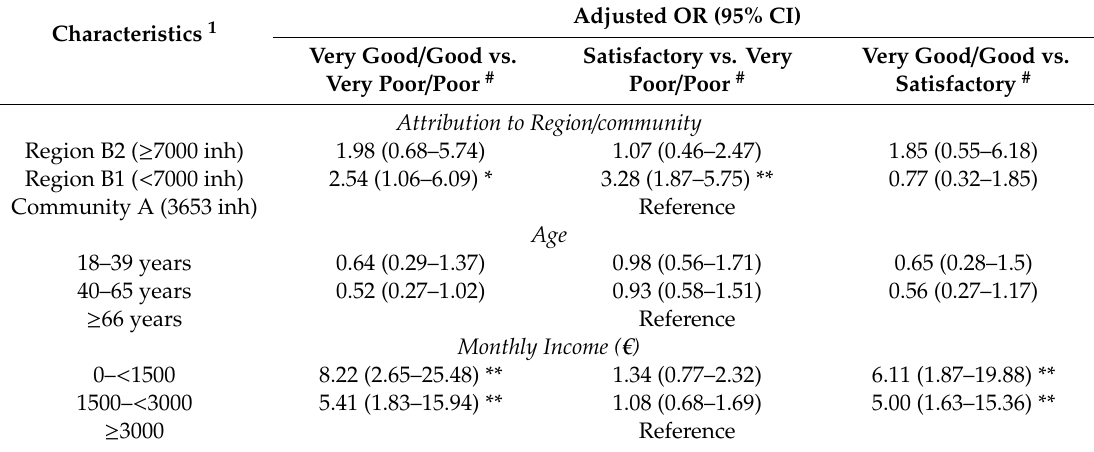
Table 4. Results of multinomial logistic regression for outcome (2) “HCS provided by specialists”. Characteristics